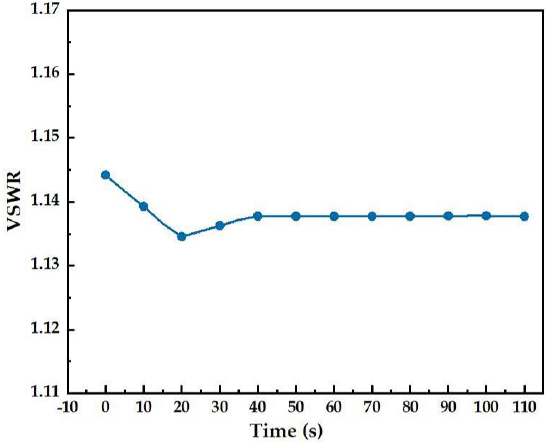
Figure 4. Variation of VSWR at different heating times.